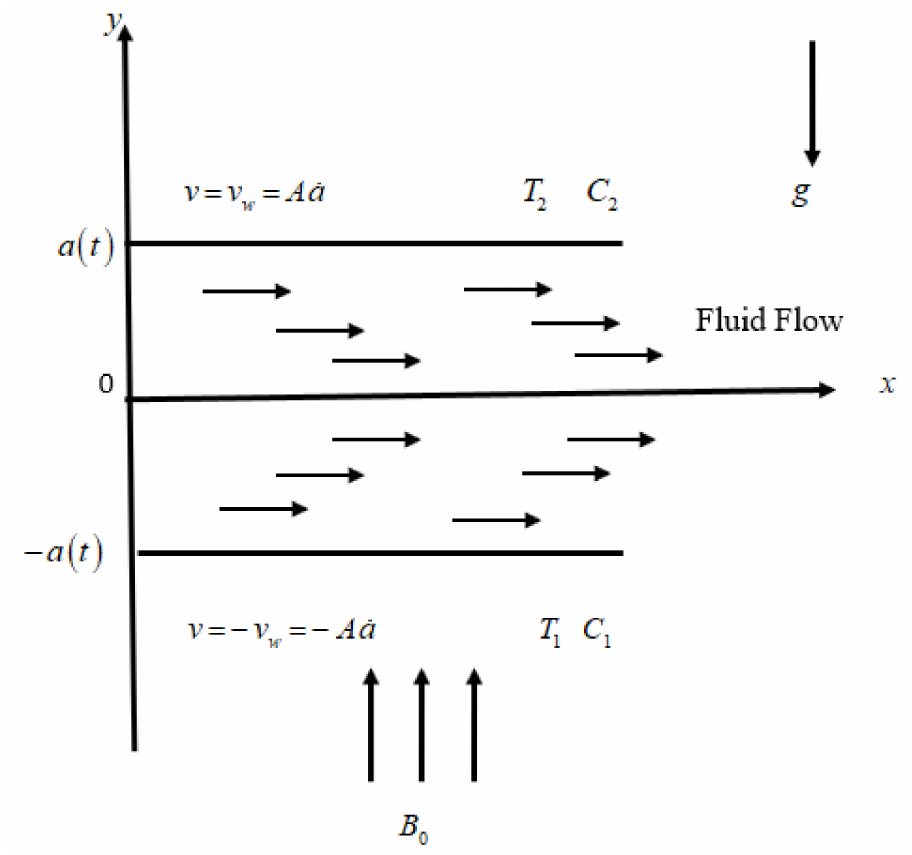
Figure 1. Flow diagram. Table 1. Nanomaterial and base fluid’s thermo-physical property values (Jamshed and Aziz [39]). S.